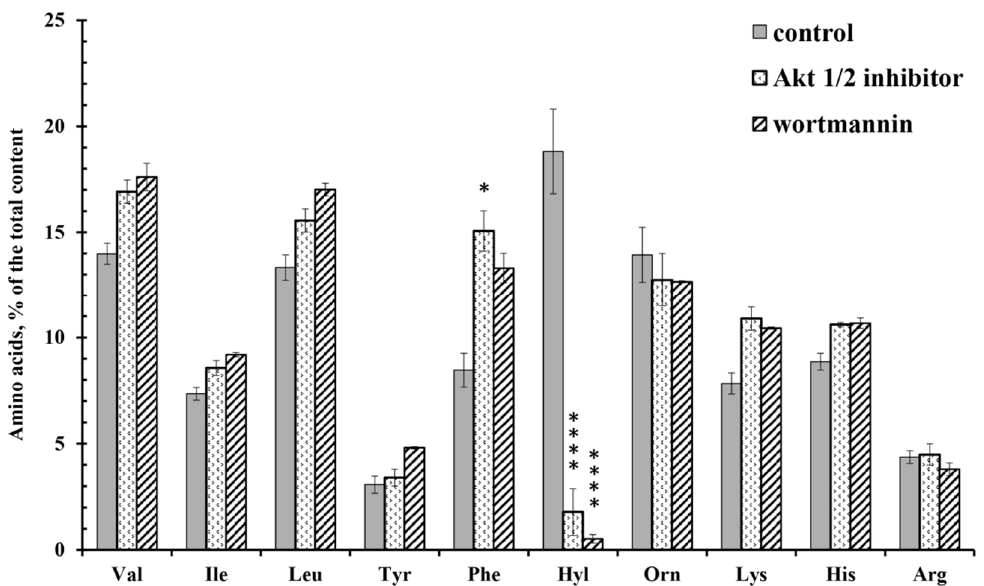
Figure 5. Free amino acid composition of secretion of the neutrophils during adhesion to fibronectin in the presence of inhibitors of PI3K/Akt pathway. Human neutrophils were incubated over fibronectin-coated substrates for 20 min in control conditions or in the presence of 25 µM Akt 1/2 inhibitor or 1 µM wortmannin. The amount of amino acid is represented as a percentage of the total content of the detected free amino acids (mean ± SEM). Amino acid profiles were obtained by summing the results of three independent experiments. *—significant differences when compared to the value for the same amino acid in the control cells (*— p < 0.01; ****— p < 0.0001). (Val—valine; Ile—isoleucine; Leu—leucine; Tyr—tyrosine;